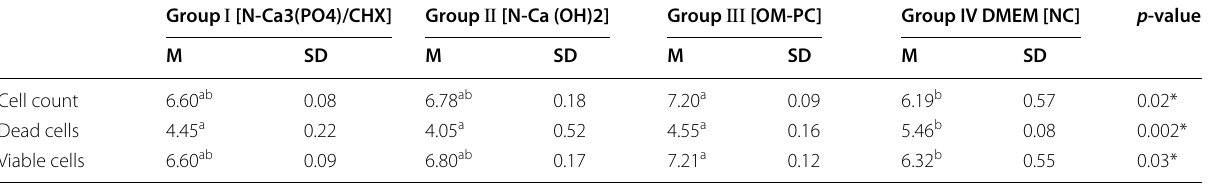
p : Probability level which is significant at p Means (M) with different superscript letters within the same horizontal row are significantly different M Mean, SD Standard deviation * P ≤